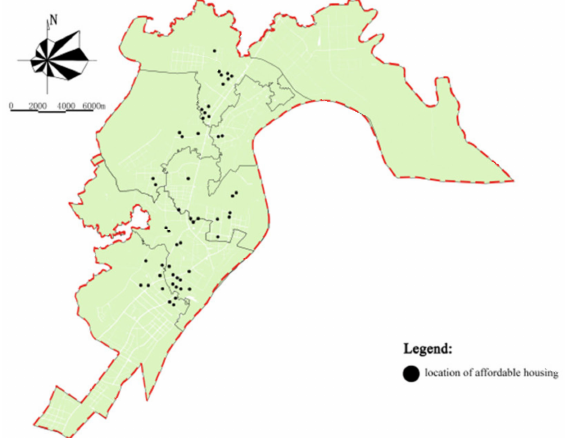
Figure 2. Spatial distribution of current affordable housing (location of affordable